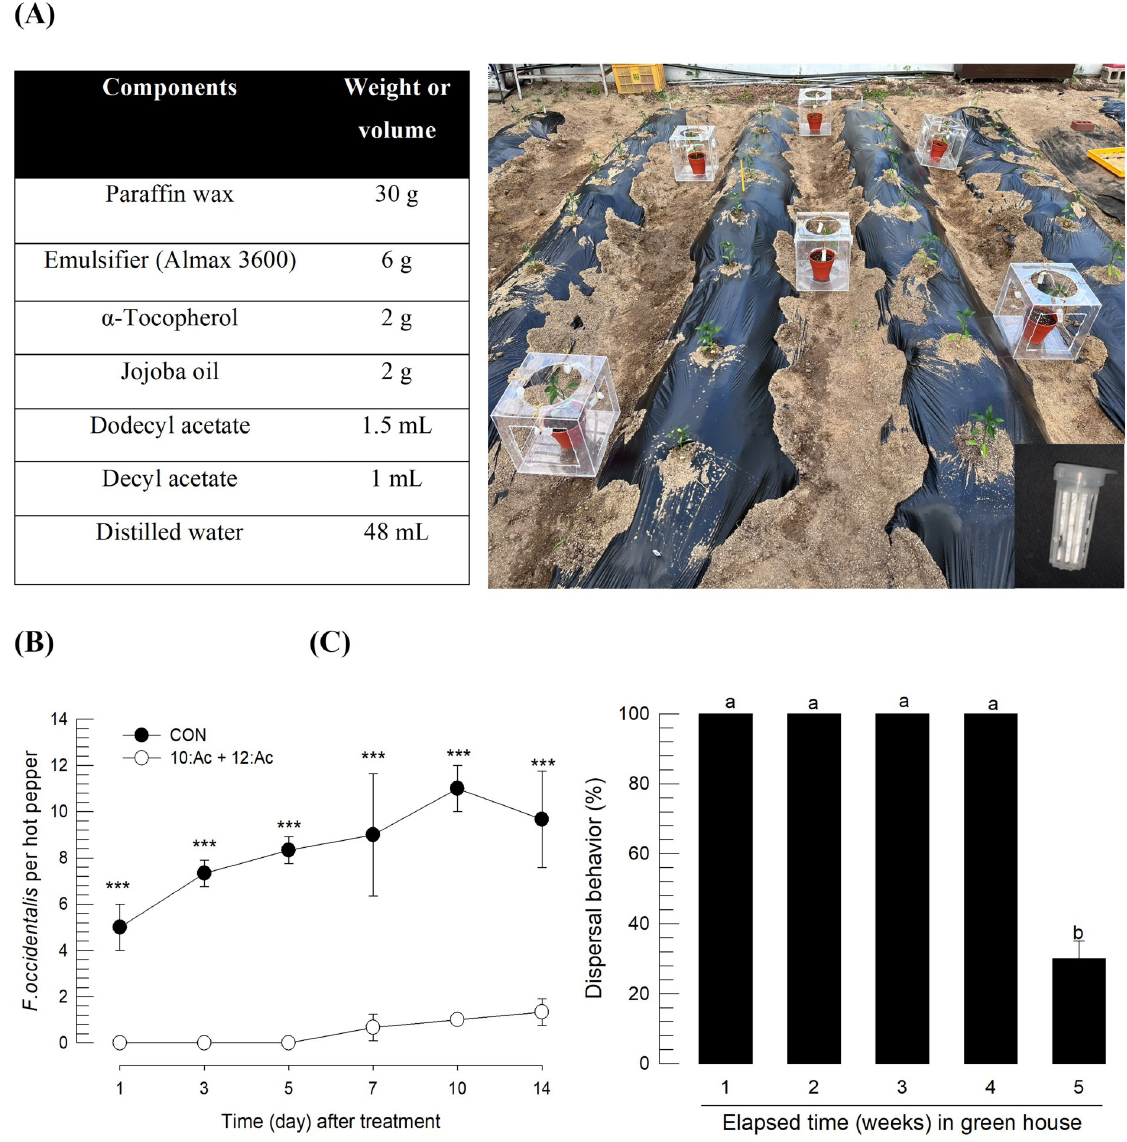
Fig 5. Field assay of alarm pheromone-based repellent efficacy against F . occidentalis in a greenhouse cultivating hot peppers. (A) Composition of the wax formulation of the repellent and installation of the wax formulations (in a small cage) in five directions around a test plant. (B) Effect of the repellent on preventing immigrating thrips for two weeks. Three asterisks above the standard deviation bars indicate a significant difference between two treatments at Type I error = 0.0001 (LSD test). (C) Determination of the effective period of the wax formulation in field conditions. Different letters above the standard deviation bars indicate a significant difference among means at Type I error = 0.05 (LSD